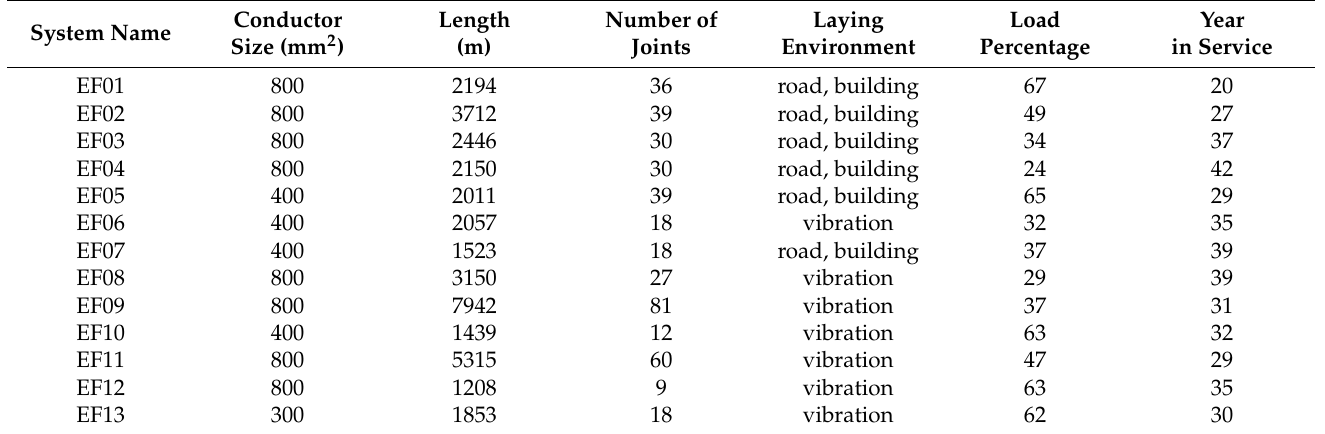
Table 4. Technical and operating information of 13 sample retired underground cable systems.